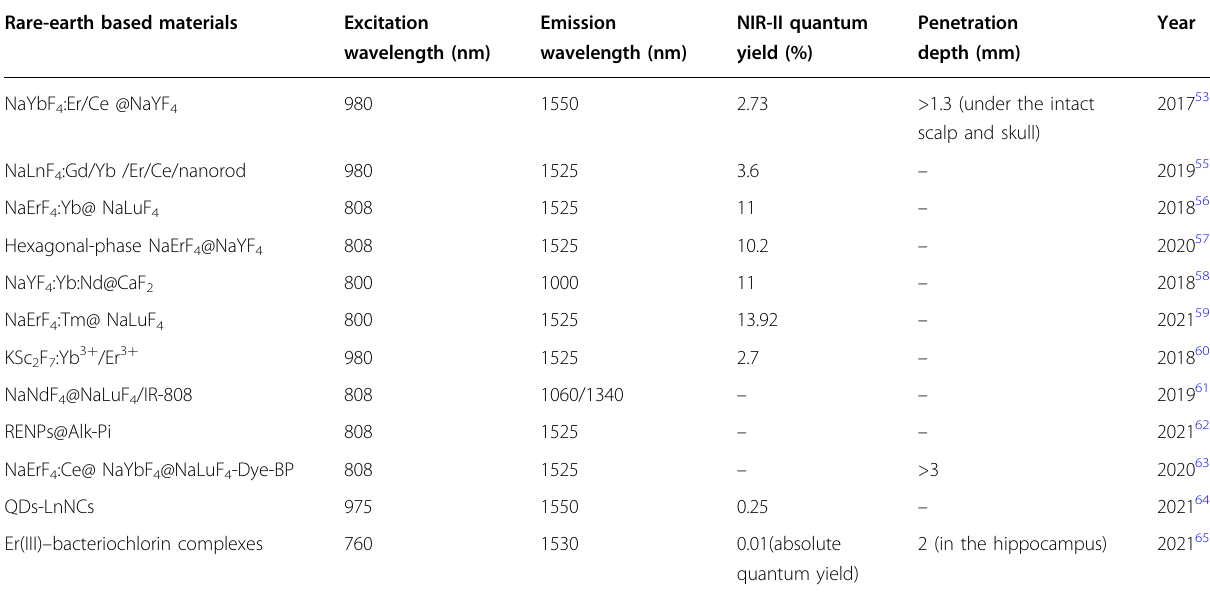
Table 1 Typical rare-earth based materials for NIR-II fl uorescence imaging Rare-earth based